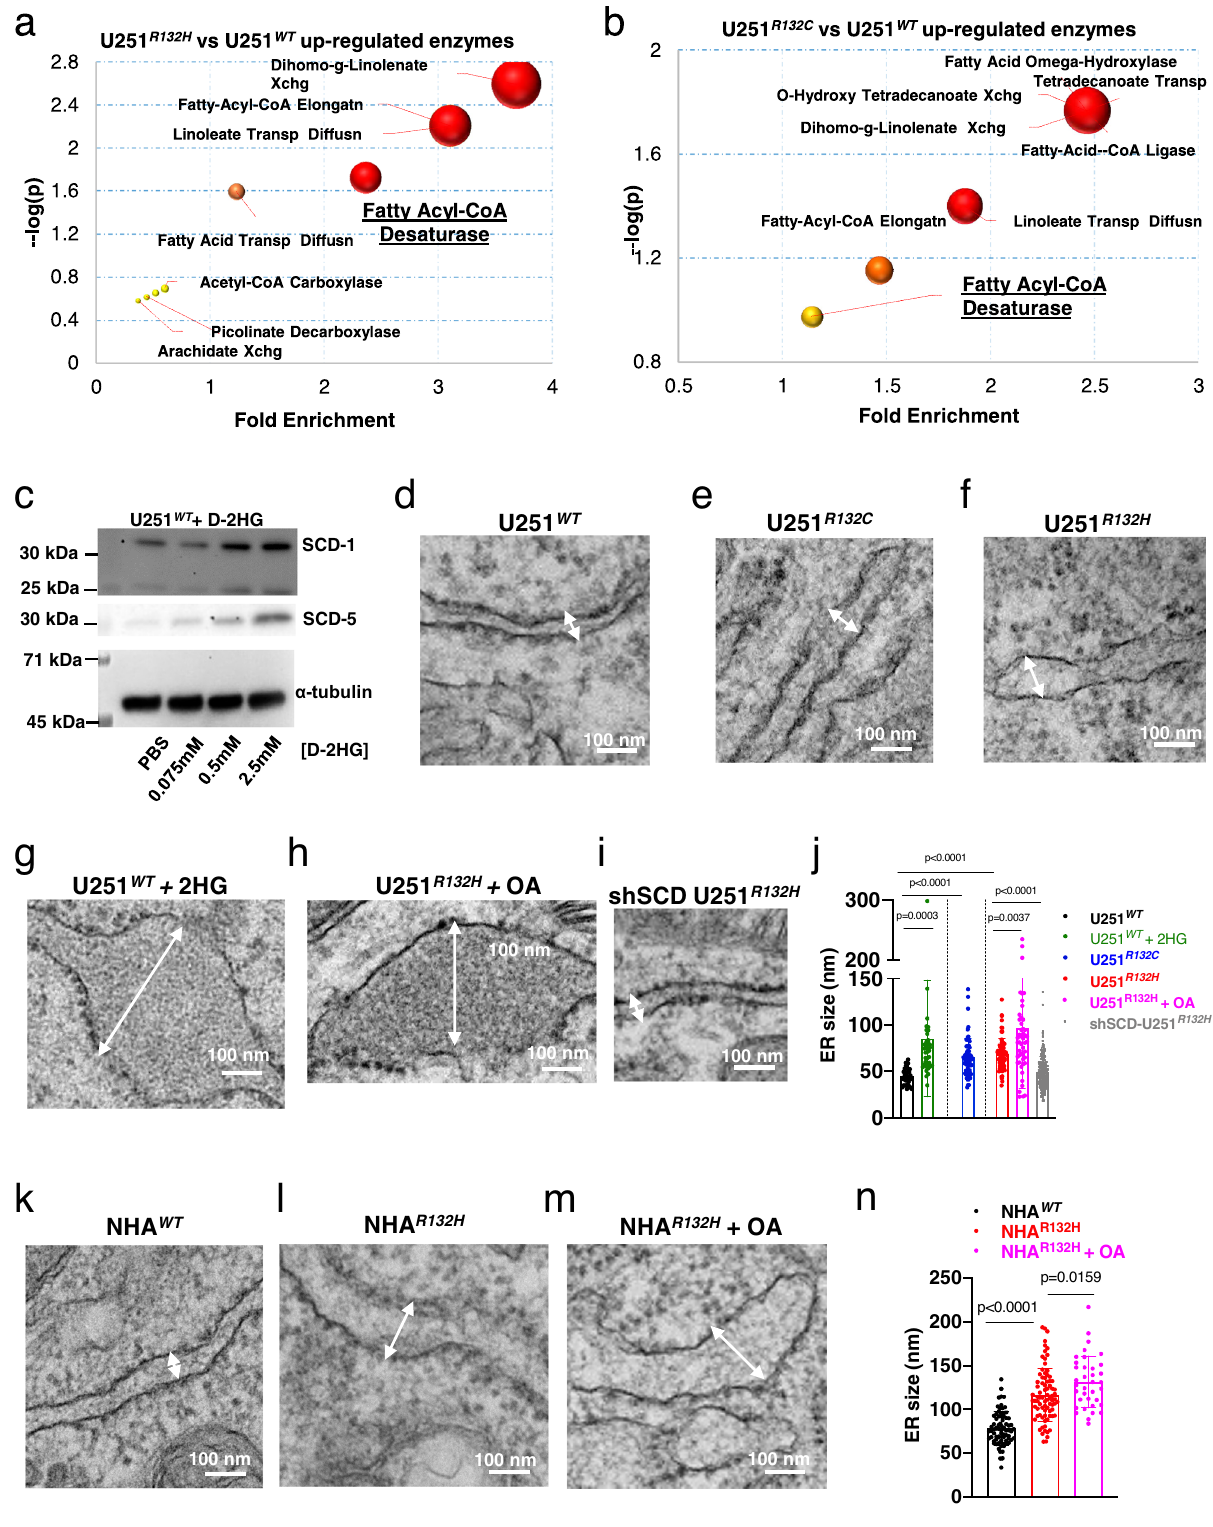
that expression of hSCDs present the highest levels in oligoden- drogliomas with IDH1 mutation amongst all the glioma subtypes, the imbalance in phospholipids is recapitulated in tumors of oligodendroglioma and correlates with ER and Golgi distorted